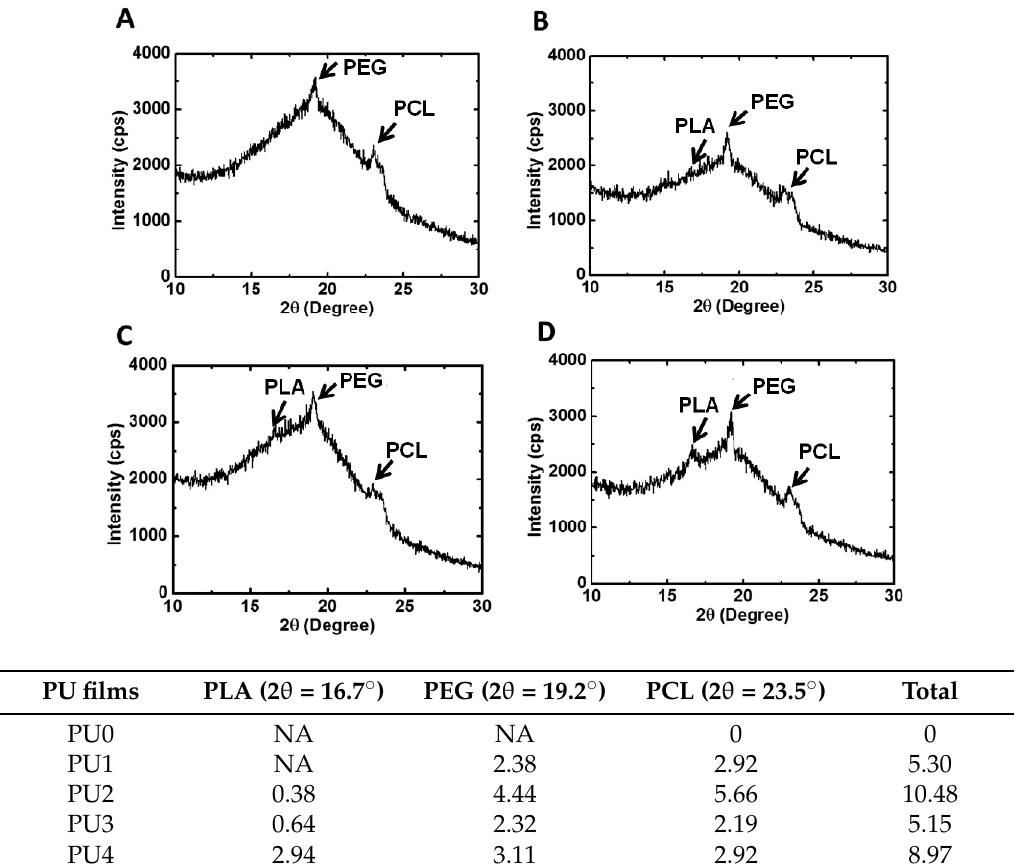
Figure 5. X-ray diffraction patterns and the degree of crystallinity of PU films: ( A ) PU1, ( B ) PU2 , ( C ) PU3 and ( D ) PU4.